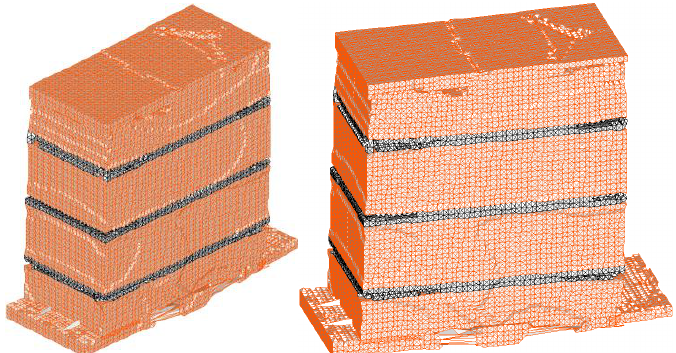
Fig. 1. The configuration of the brick masonry 4×1 is affected by the rectangular impulse with the time duration of 2541,7 ms and at the speed of 6,1 m/s in the starting moment and in the time moment 4007